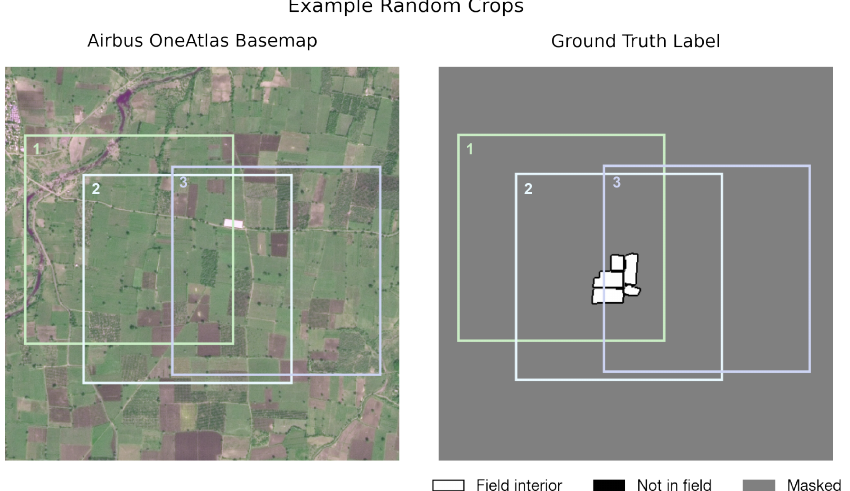
Figure A2. Random image crops to increase effective dataset size. We downloaded 512 × 512 pixel images around the labeled fields in India; at training time, a random crop of the image was taken. Compared to downloading 256 × 256 pixel images, this allows the model to see more diverse images, expanding the effective dataset size and delaying